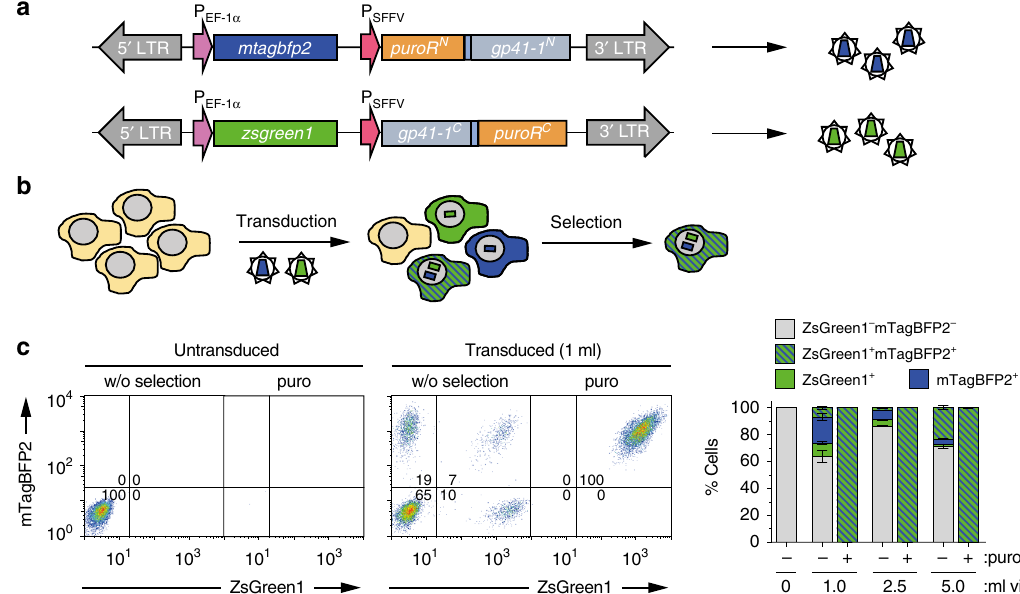
Fig. 8 SiMPl can be used to select human T cells with puromycin. a Schematic of the SiMPl lentiviral vectors encoding mTagBFP2 and ZsGreen1 where the puromycin acetyltransferase is split at position V82:E83. b Schematic of the work fl ow. c T cells selected on puromycin after transduction with the two lentiviruses in ( a ) are 100% positive for mTagBFP2 and ZsGreen1. Left panel, representative fl ow cytometric analysis of mTagBFP2 and ZsGreen1 expression in living cells gated using forward versus side scatter. The numbers indicate the percentage of mTagBFP2- and/or ZsGreen1-positive cells in the indicated quadrants. Right panel, stacked bar chart showing the percentage of cells in the four quadrants (lower left, ZsGreen1 − mTagBFP2 − ; lower right, ZsGreen1 + mTagBFP2 − ; upper left, ZsGreen1 − mTagBFP2 + ; upper right, ZsGreen1 + mTagBFP2 + ) at the indicated conditions. Values represent mean (± standard deviation) of three independent experiments. Standard bar graphs with individual data points are shown in Supplementary Fig. 20. Source data are provided as a Source Data fi